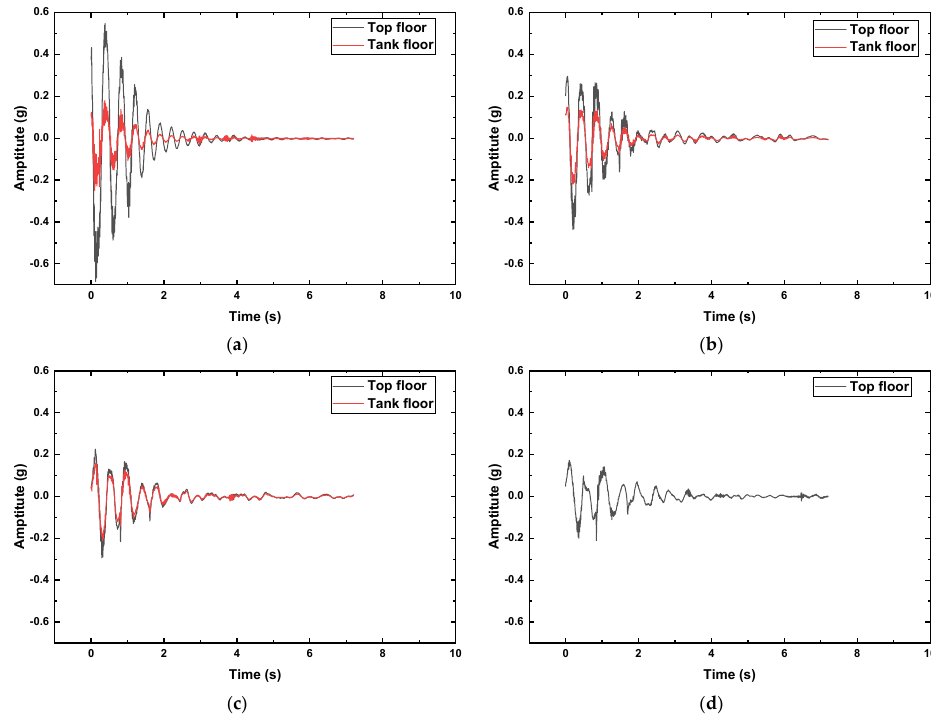
Figure 6. The accelerations when the water tank with a water level of 4 cm is placed on each floor of the structure. ( a ) 2nd floor; ( b ) 3rd floor; ( c ) 4th floor; ( d ) 5th floor.